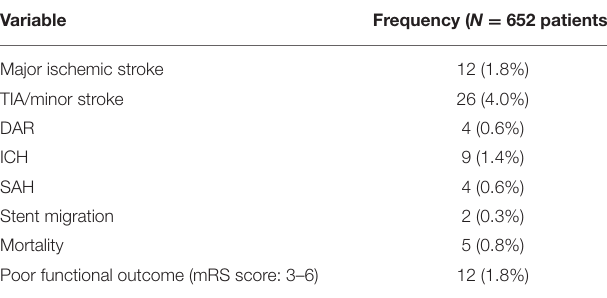
TABLE 5 | Complications during the early postoperative